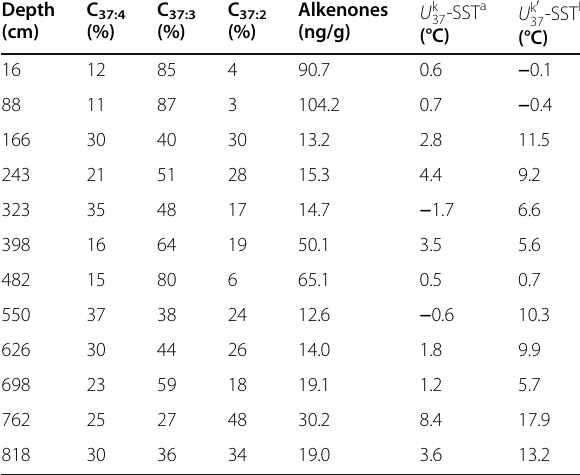
Table 2 The relative abundance and concentrations of C 37:4 , C 37:3 , and C 37:2 alkenones and based on U k subsamples with different sediment depth of core R23